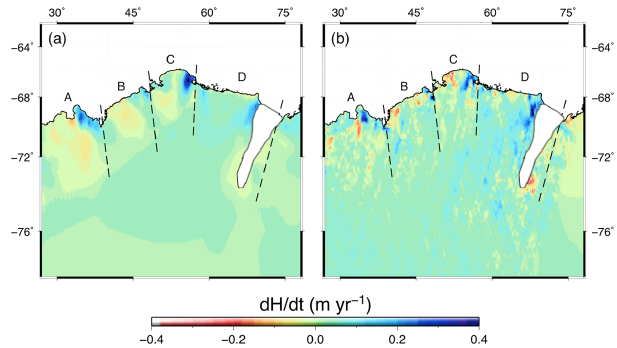
Figure 6. (a) Our modelled rate of change of surface elevation re- trieved by removing our estimated ice dynamic rates, obtained from GRACE, from the modelled trend in surface elevation (SMB minus firn compaction) using RACMO2.3, compared to (b) the ICESat